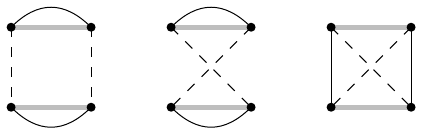
Figure 1 . The base case for the lemma. Thick grey edges are B , thin black edges are P , and thin dashed edges are the possibilities for Q